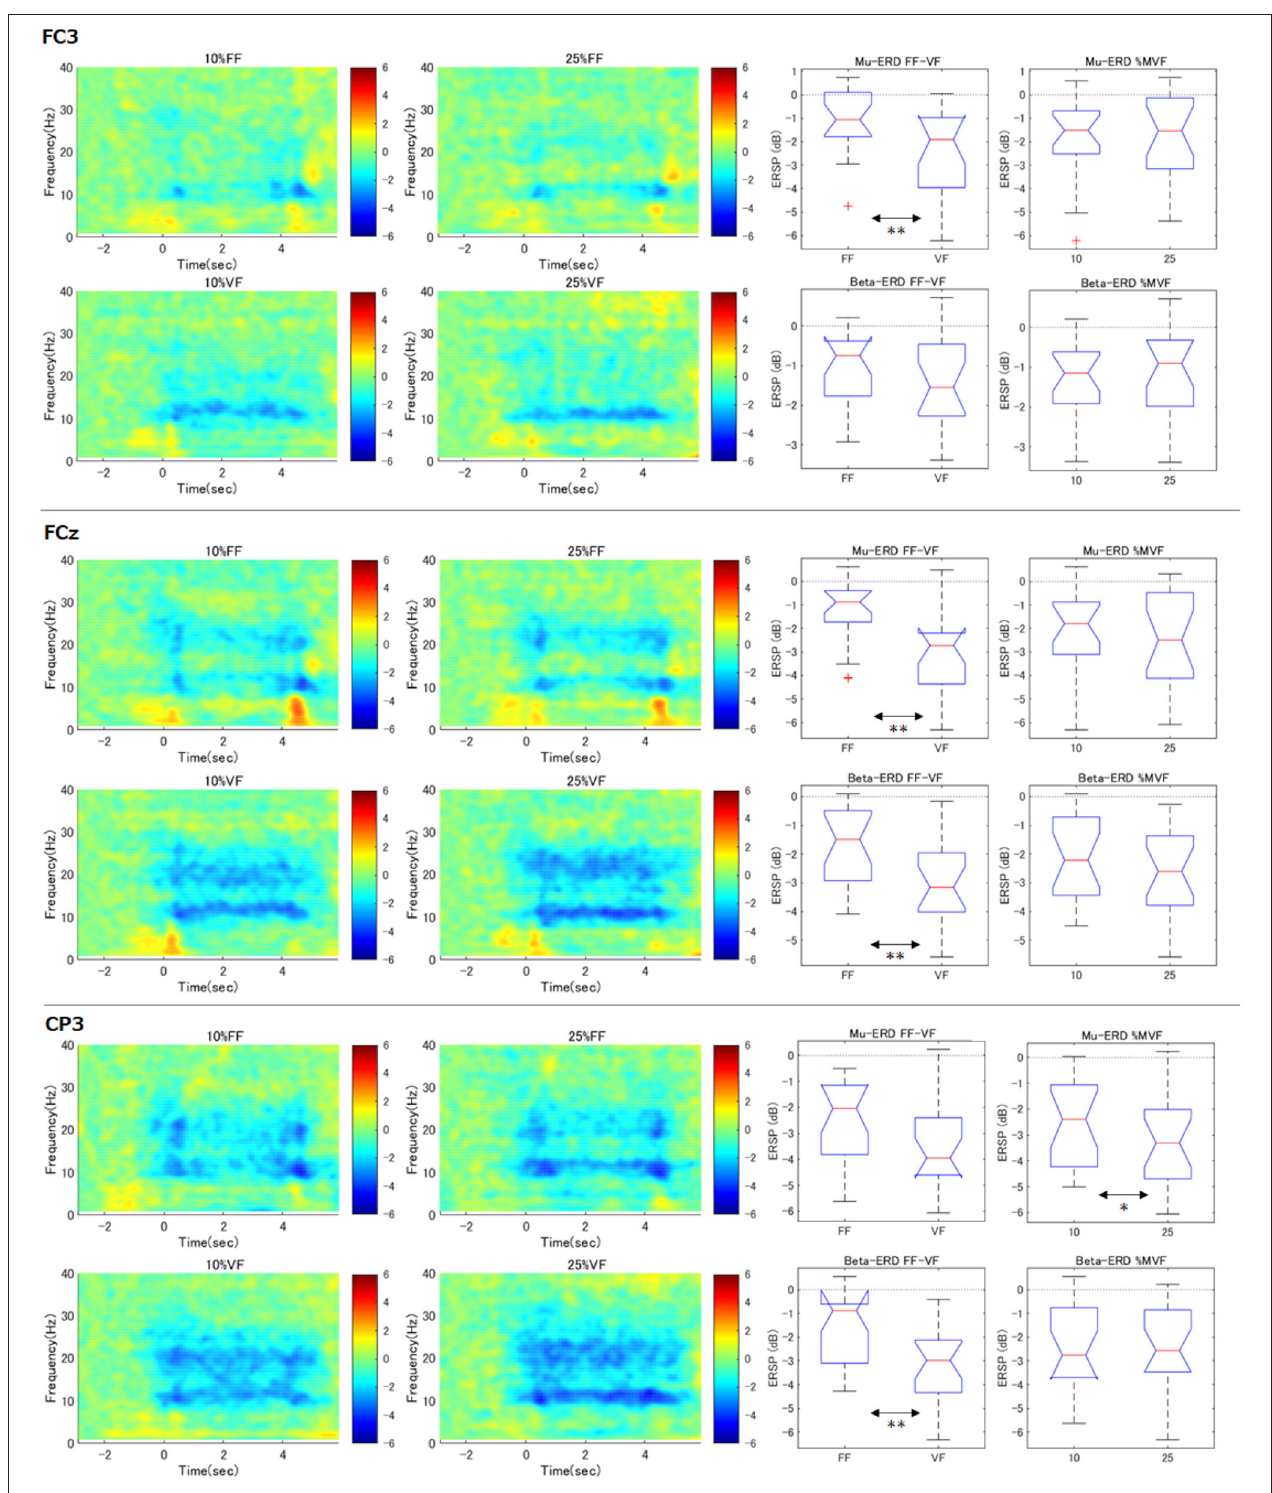
FIGURE 5 | Time-frequency maps of ERD/S and comparison of ERD during maintenance of grasping (FC3, FCz, CP3). The same analysis as for C3 was performed for the surrounding channels. The trend of the tilt time-frequency map is similar to that of C3. Statistical tests on the resultant ERD during maintenance of grasping in FF condition showed that mu/beta-ERD for FCz, mu-ERD for FC3, and beta-ERD disappeared for CP3. only in CP3, mu-ERD occurred significantly more strongly when the load was strong (** p < 0.01, * p < 0.05).